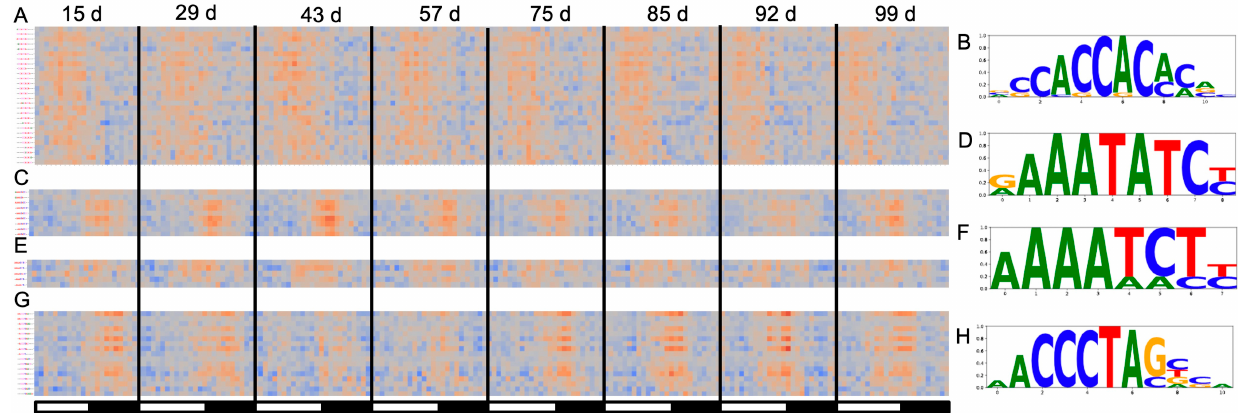
Figure 4. Element analysis across the developmental time course. ( A ) The Morning Element (ME; CCACAC) displayed morning-specific overrepresentation; ( B ) the logo plot of the significant ME 3–8 bp kmers found in ( A ); ( C ) the Evening Element (EE; AAATATCT) displayed evening/dusk- specific overrepresentation; ( D ) the logo plot of the significant ME 3–8 bp kmers found in ( C ); ( E ) the CCA1 Binding Site (CBS; AAAATCT) displayed evening/dusk-specific overrepresentation; ( F ) the logo plot of the significant ME 3–8 mers found in ( E ); ( G ) the Telobox (TBX; AAACCCT) displayed midnight-specific overrepresentation; ( H ) the logo plot of the significant ME 3–8 bp kmers found in ( G ). The white and black bars represent relative day and night, respectively.